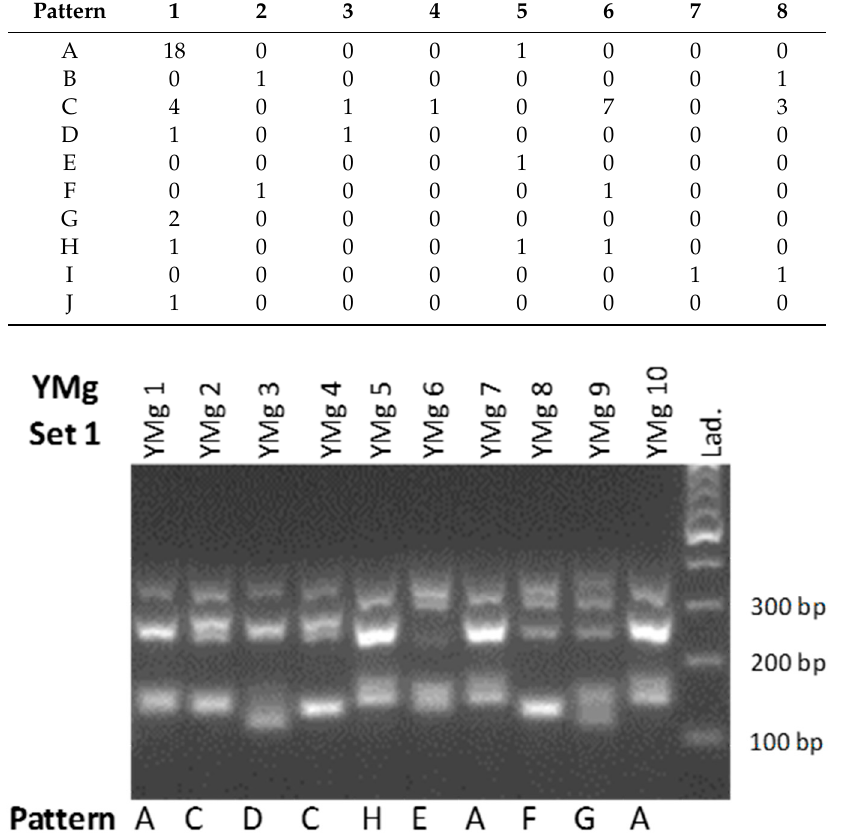
Figure 4. Example of an agarose gel showing the patterns A and C–H. The fragment lengths in base pairs (bp) for the yeast strains Ymg 1–10, amplified with the primer set 1, are shown. Table 4. Number of patterns obtained by gel electrophoresis for the winery’s own yeast after SSR PCR using multiplex set 1 (1 to 8) and multiplex set 2 (A to J).